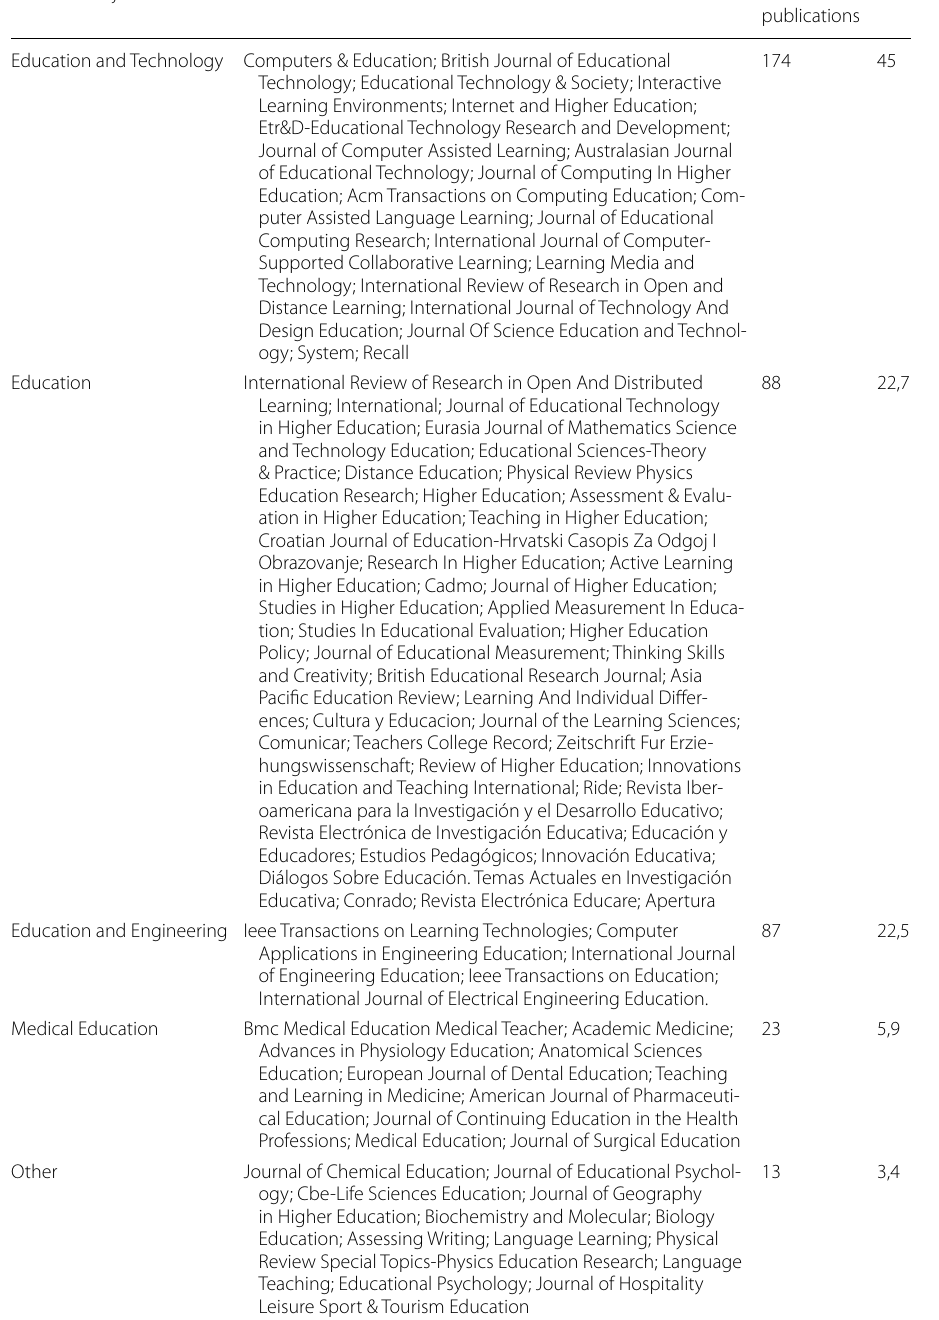
Table 2 Publications per Focus of the Journals in SciELO and WoScc databases